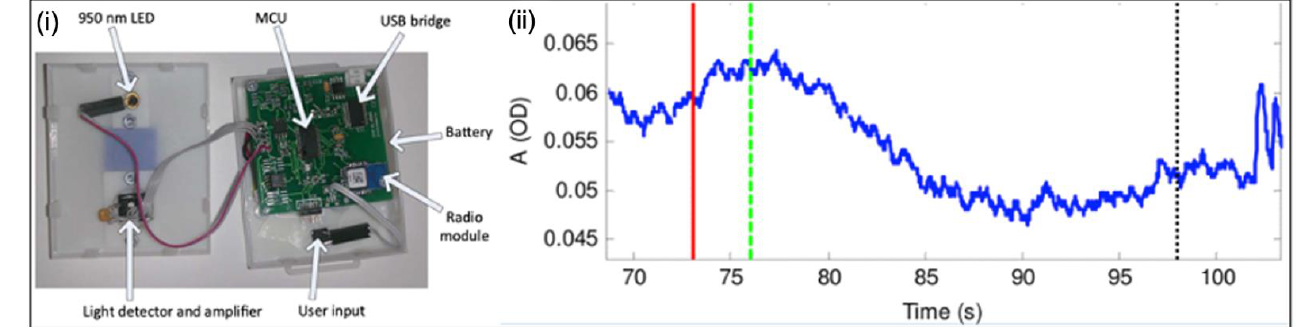
Figure 4. Near-infrared spectroscopy method. ( i ) NIRS device used for monitoring urine in the bladder; ( ii ) attenuation detection during voiding. The red, green and black lines are permission to void, beginning and end of voiding, respectively [87]. Copyright 2014, IEEE.